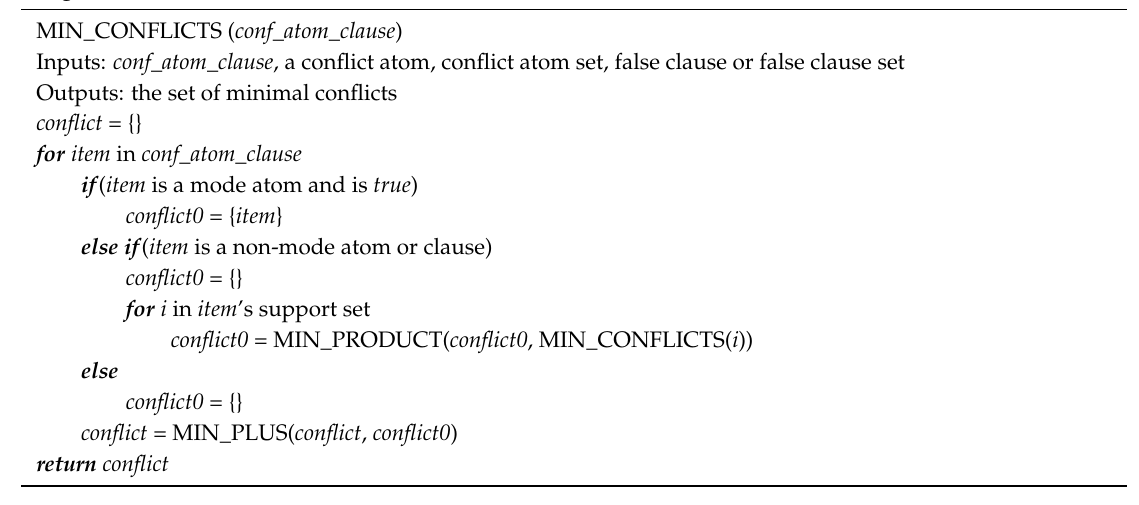
Algorithm 3. Pseudocode of MIN_CONFLICTS for MCMC-LTMS.